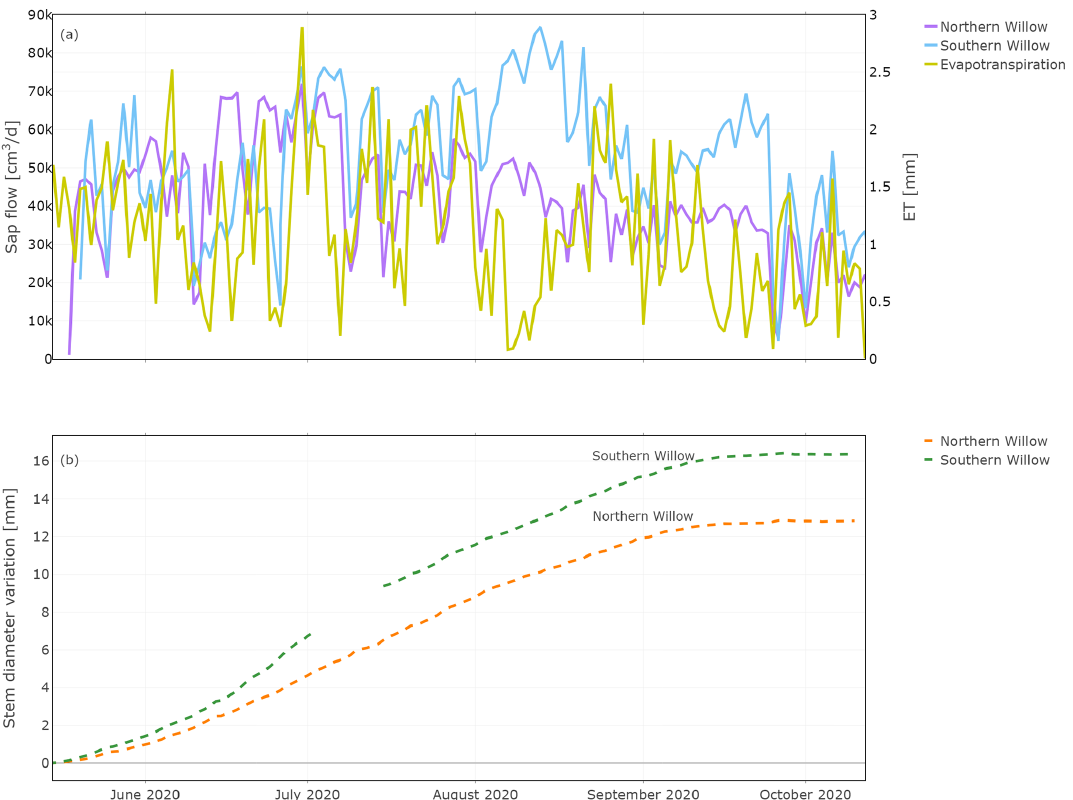
Figure 4. Daily total sap flow measured at the southern stem side and stem diameter variation measured for the stem radius at the northern stem side. Plot (a) shows the results of sap flow together with evapotranspiration for comparison and (b) the results of the stem diameter variation during the measuring